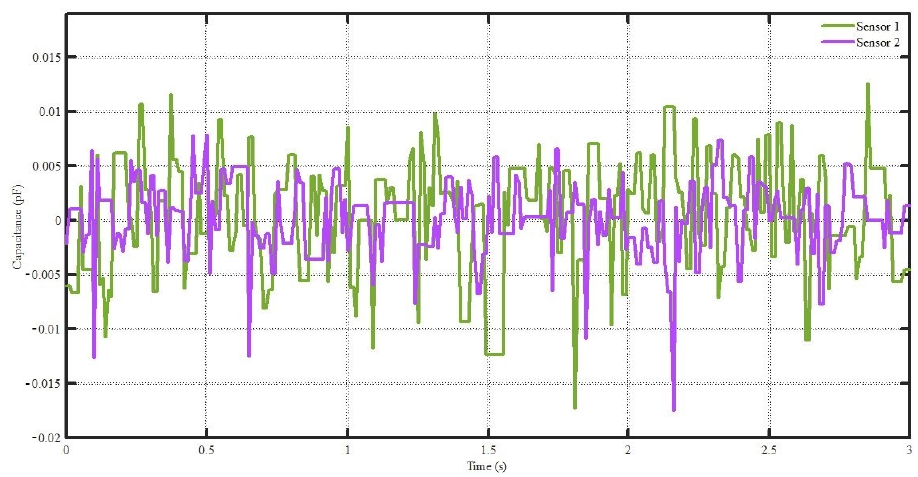
Figure 13. The normalized output of electric sensors. The outcome of the cross-correlation of the normalized results of sensors 1 and 2 is shown in Figure 14. At the sixth instant, the greatest peak of the output signal arrives. As can be seen, the sand particles require an average of 60 milliseconds to move from sensor 1 to sensor 2. According to Equation (3), the velocity mean of the sand particles is 1.916 m/s.